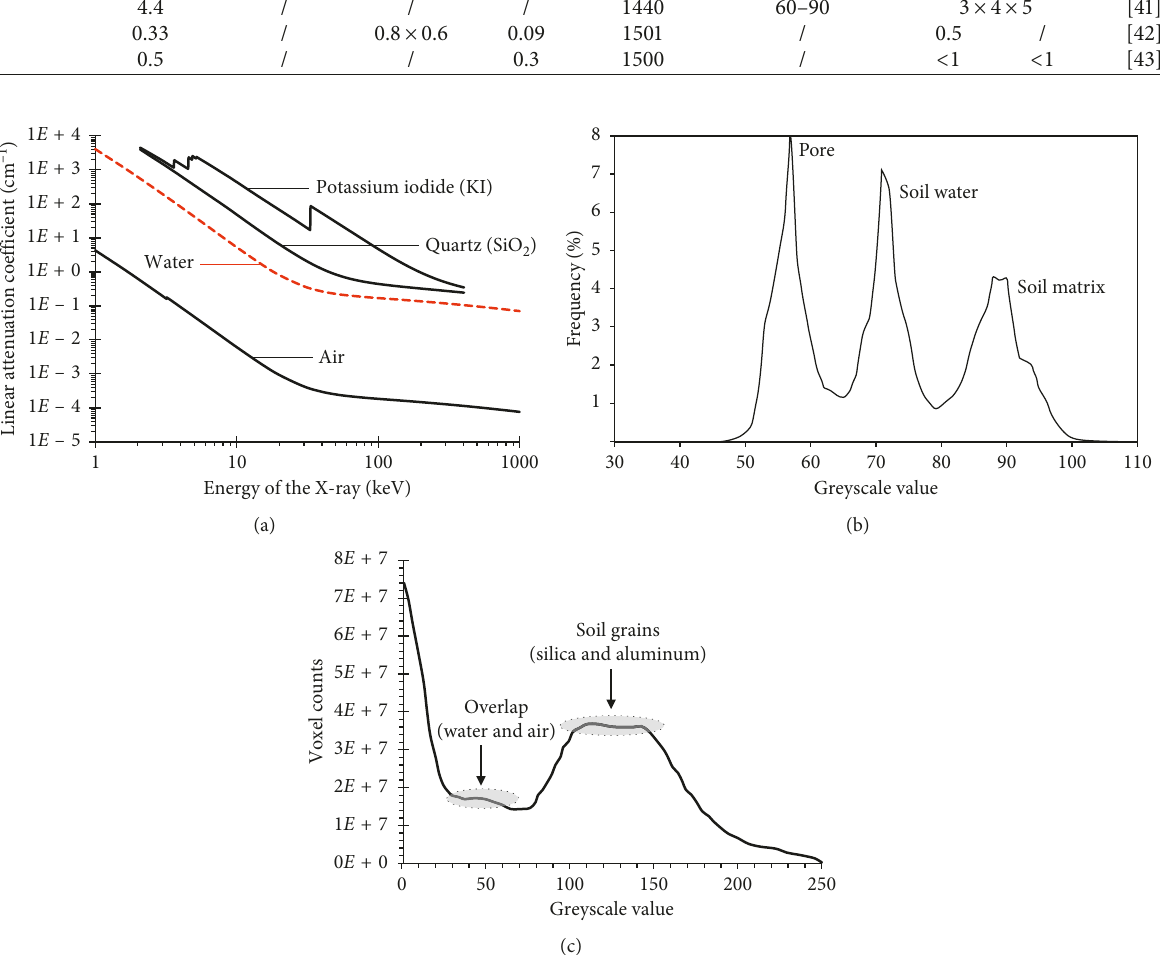
Figure 1: Linear attenuation coefficient of different phases in soil and the corresponding greyscale histogram. (a) Linear attenuation coefficients of air, water, quartz, and potassium iodide at X-ray energies from 1 to 1000keV (data from [45] and the online FFASTdatabase of the National Institute of Standards and Technology, USA). (b) Greyscale histogram of an undisturbed loess (from [46]). (c) Greyscale histogram of a compacted sand (from